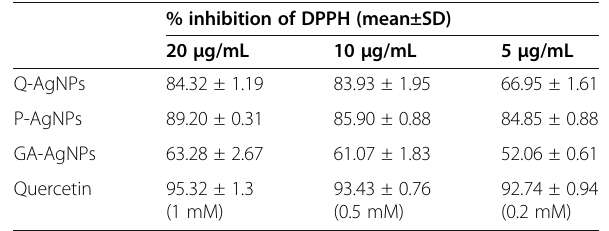
Table 3 In vitro antioxidant activity of biosynthesized AgNPs